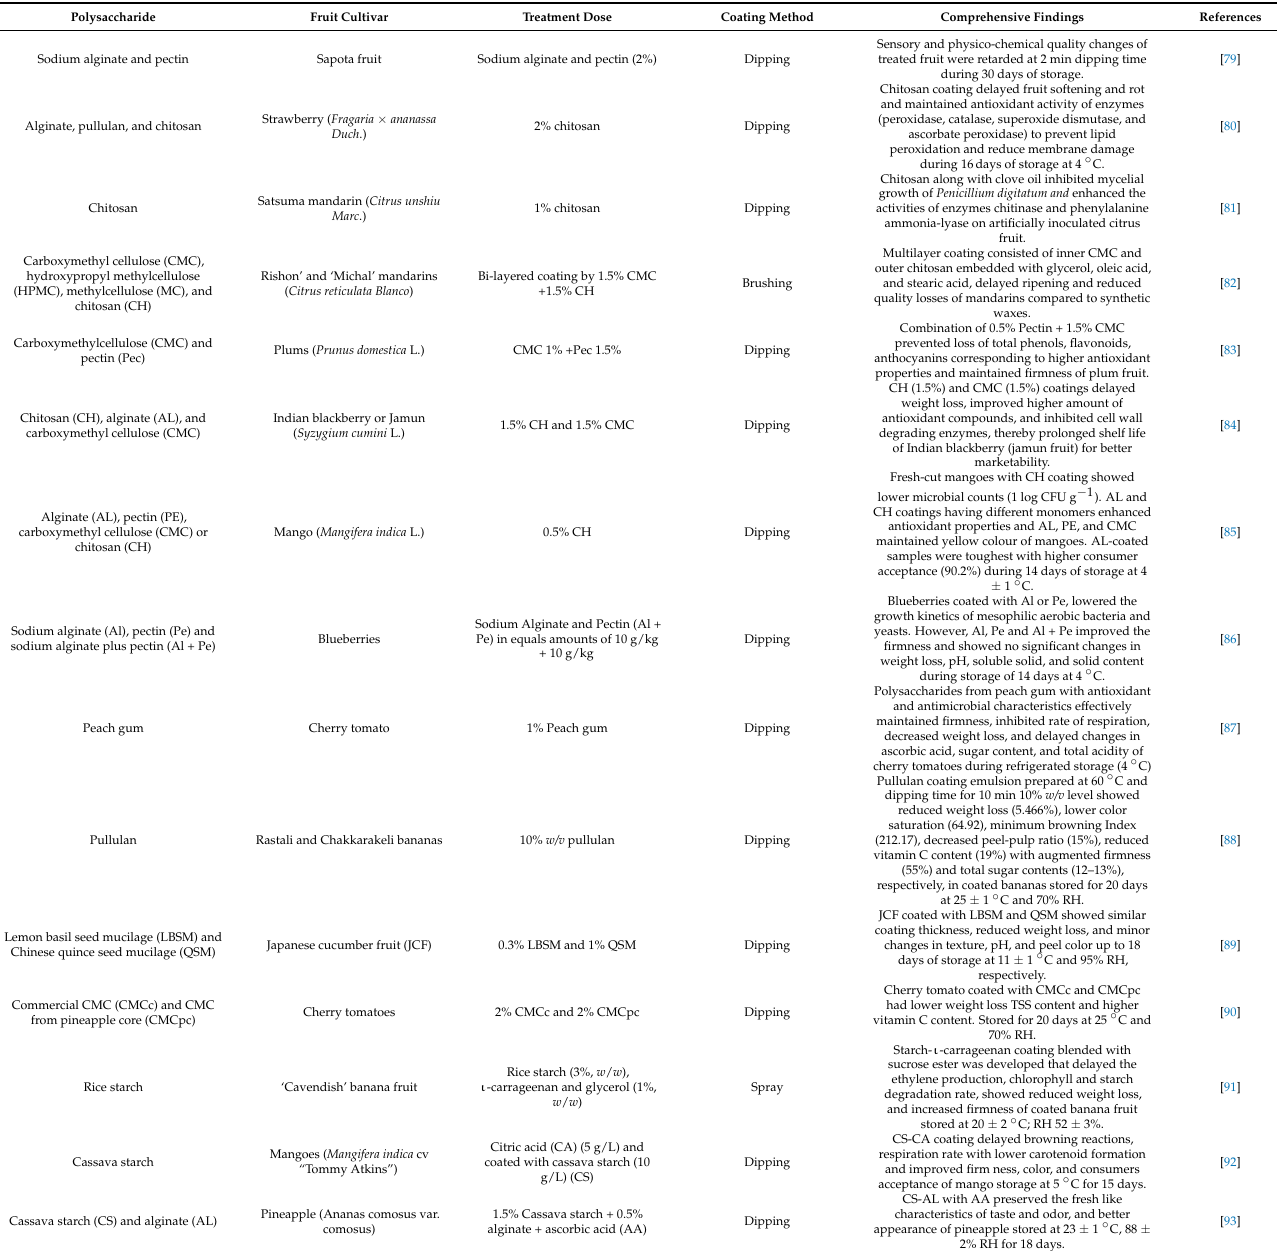
Table 1. Polysaccharide-based biodegradable and edible coatings for the quality preservation of fresh fruits during postharvest storage.